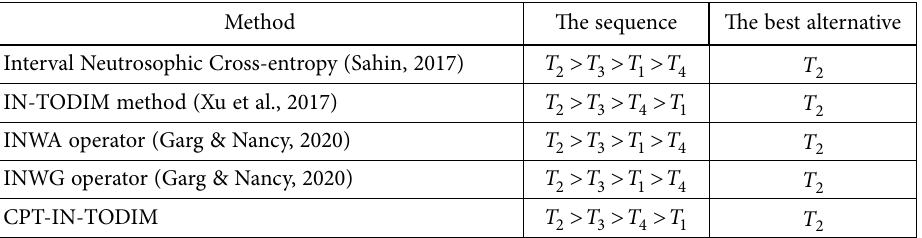
Table 13. The sequence from different methods Method The sequence The best alternative Interval Neutrosophic Cross-entropy (Sahin, 2017) > > > 2 IN-TODIM method (Xu et al., 2017)